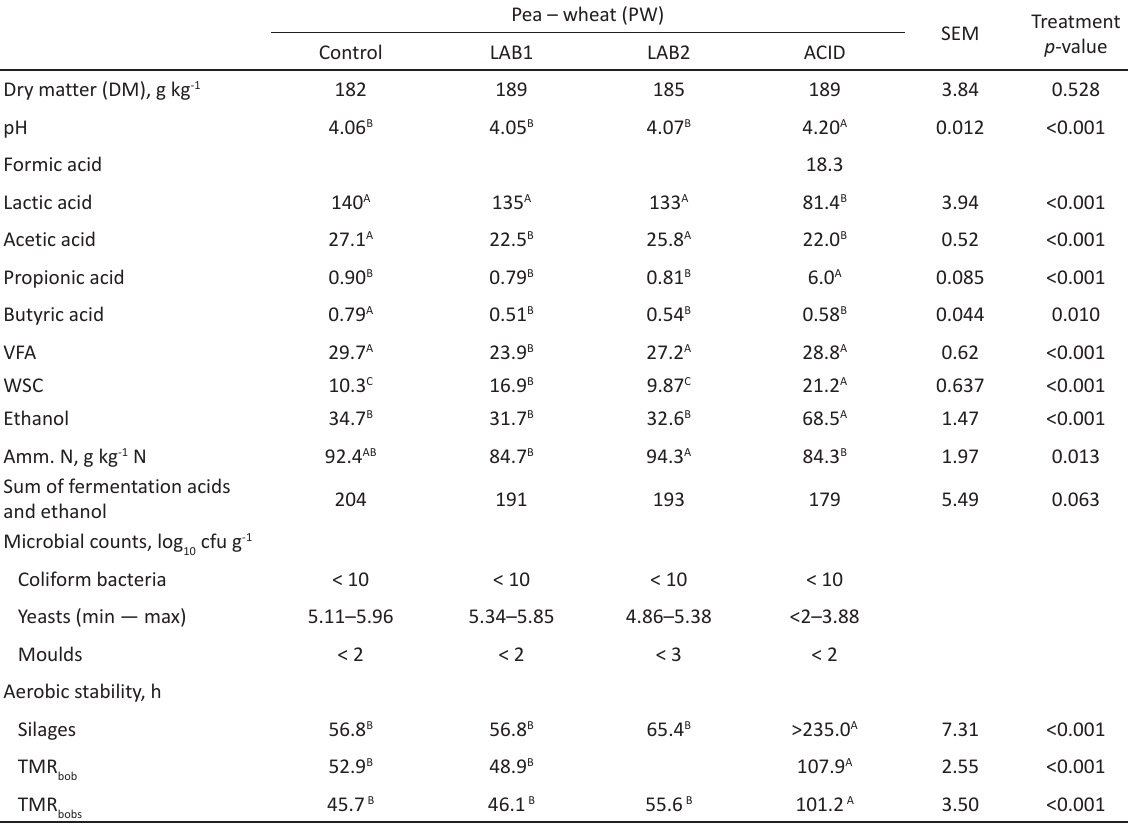
Table 4. Fermentation quality (g kg -1 DM) and aerobic stability of the Pea – wheat (PW) silages and TMR’s Pea – wheat